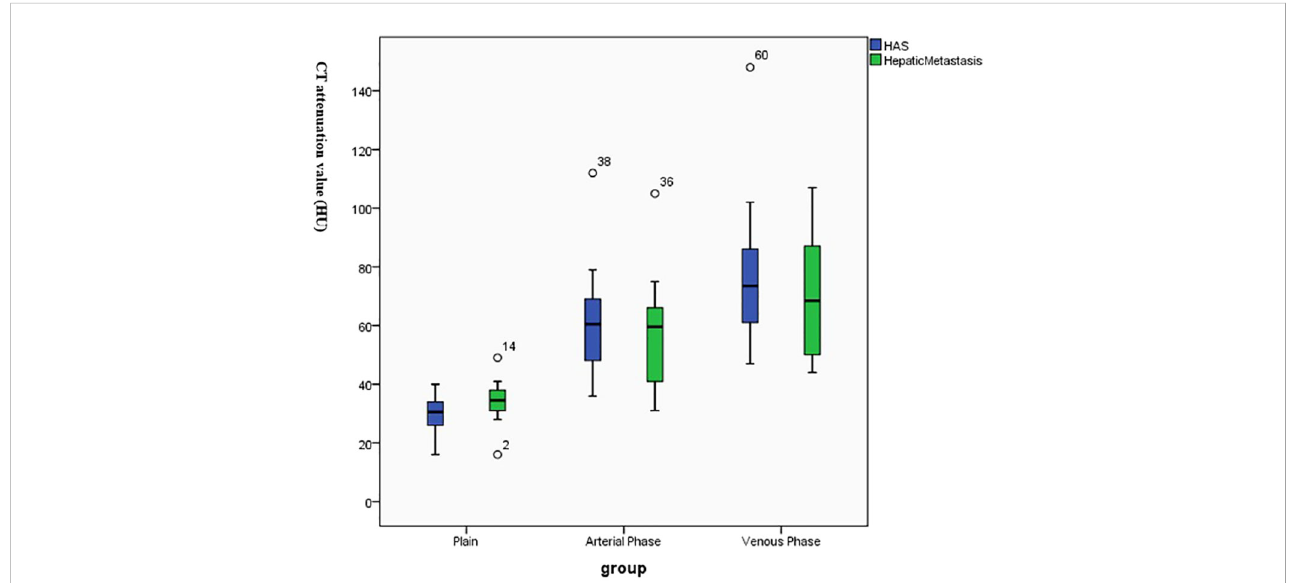
FIGURE 1 Continuous enhancement of hepatoid adenocarcinoma of the stomach (HAS) and hepatic metastatic lesions on enhancement